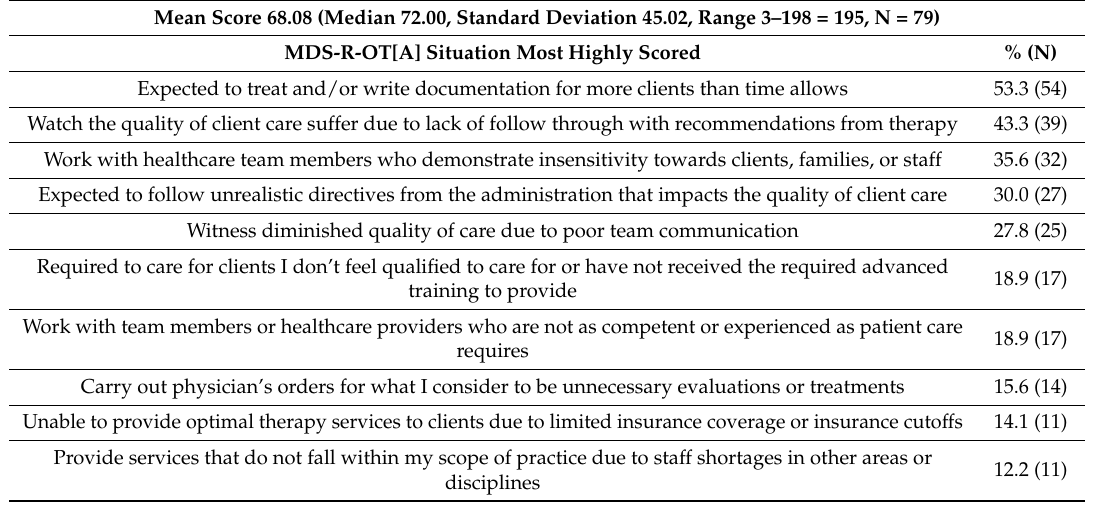
Table 3. MDS-R-OT [A] score and top ten scored situations reported to cause moral